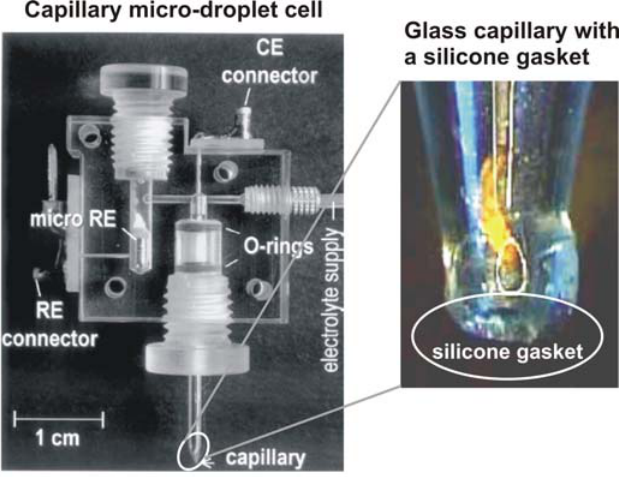
Figure 3. Photo of the ISFETs’ wafer-level testing system.